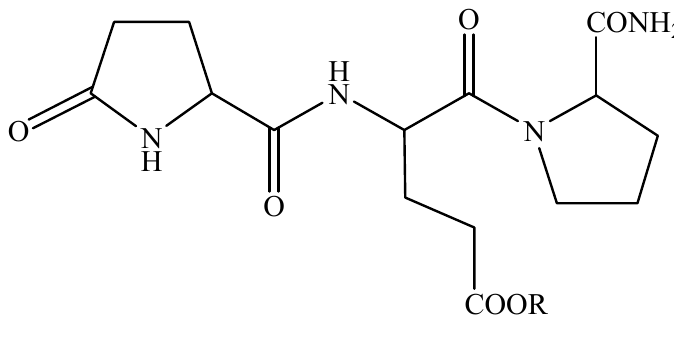
Figure 3 . Structure of [Glu 2 ]TRH prodrugs as potential CNS